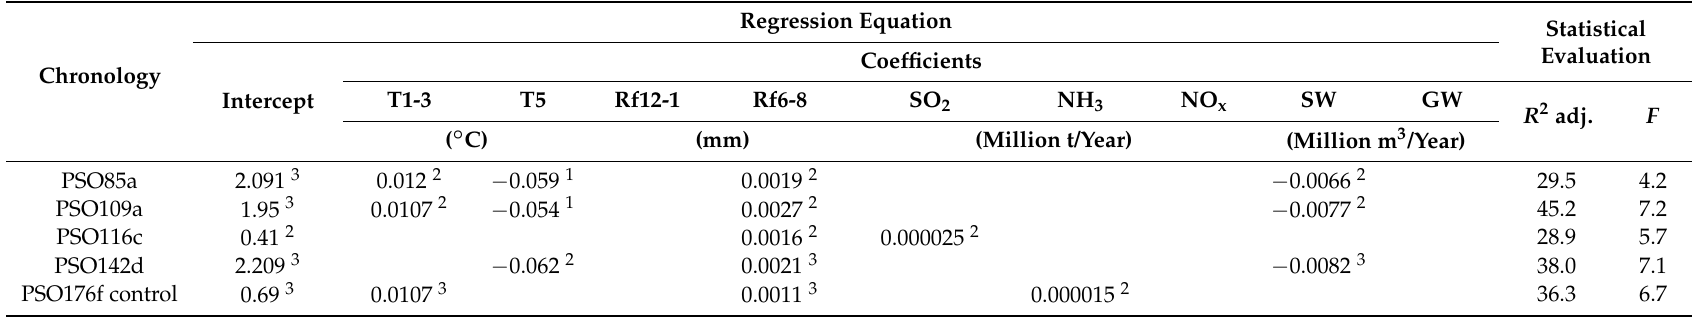
Table 7. Total influence of meteorological elements and anthropogenic factors related to the activity of Zakłady Azotowe Puławy for residual site chronologies of Scots pine